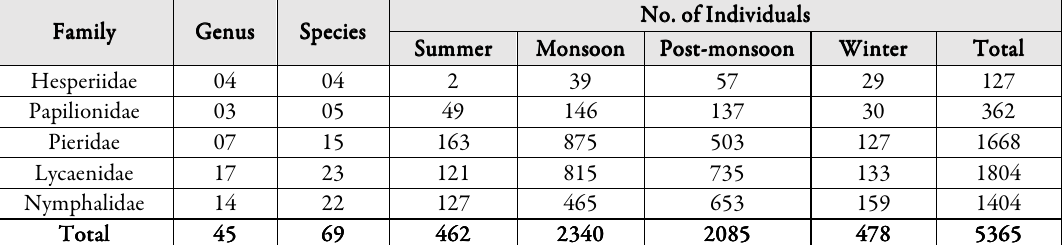
Table 1. Family-wise composition of butterfly community in the study area Family